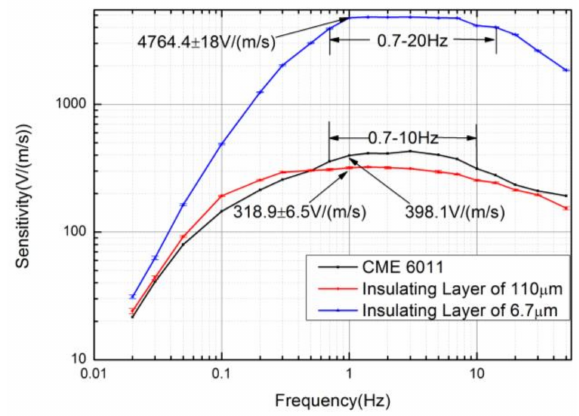
Figure 4. The sensitivities of the electrochemical seismic sensors that relied on parylene substrates and silicon substrates, as well as commercial seismic sensor CME6011. The insulating layer made of parylene was quantified as 6.7 µ m in thickness, and that made of silicon wafer was 110 µ m in thickness. The ultra-thin insulating layers based on parylene were observed to produce a significant increase in device